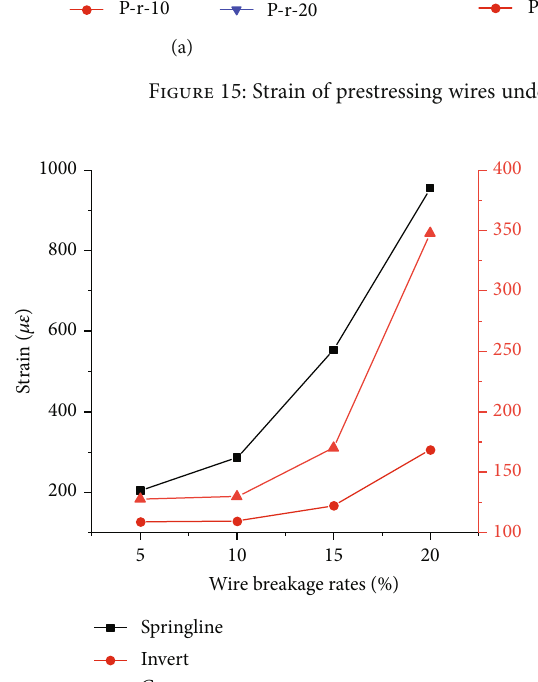
Figure 16: Strain of CFRP under combined